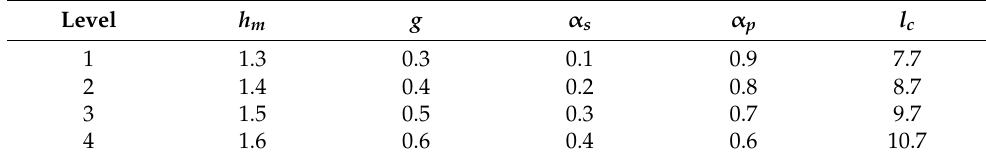
Table 2. Adjustable factor level configuration